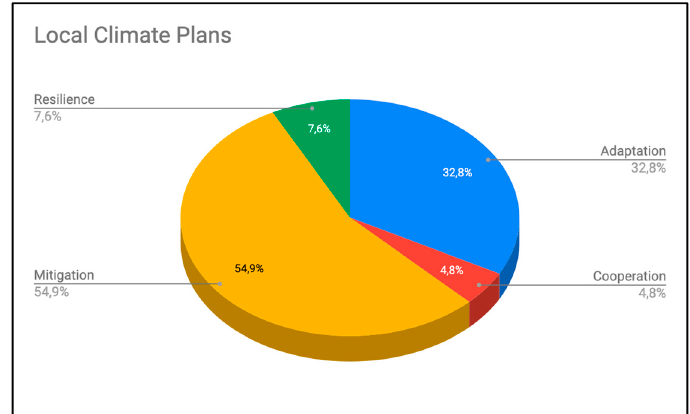
Figure 7. Climate action references in local climate plans.